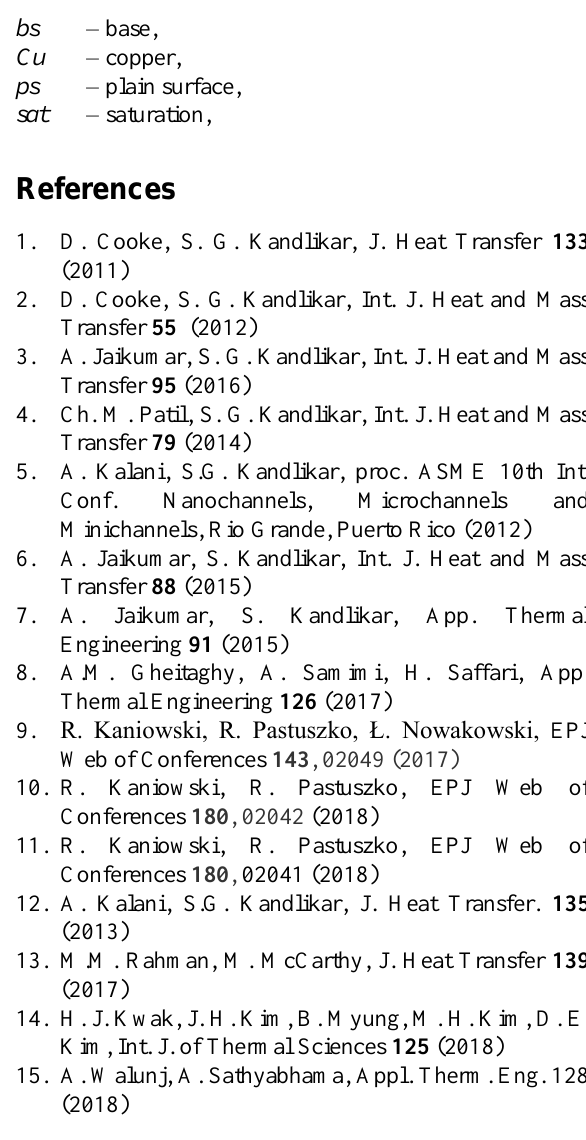
Visualization studies allowed the recognition of a two-stage bubble growing mechanism: initially at the bottom of the microchannel, and later at the top of the microfins that limit the